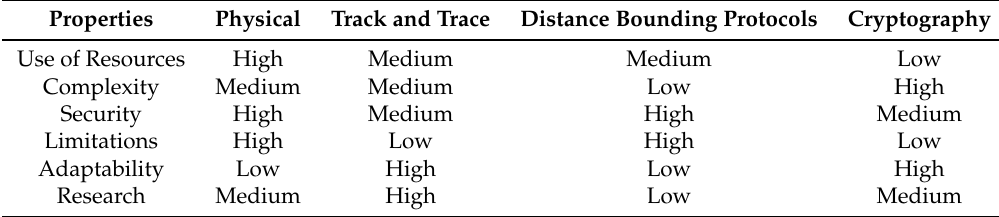
Table 1. A comparison between the four anti-counterfeiting methods.